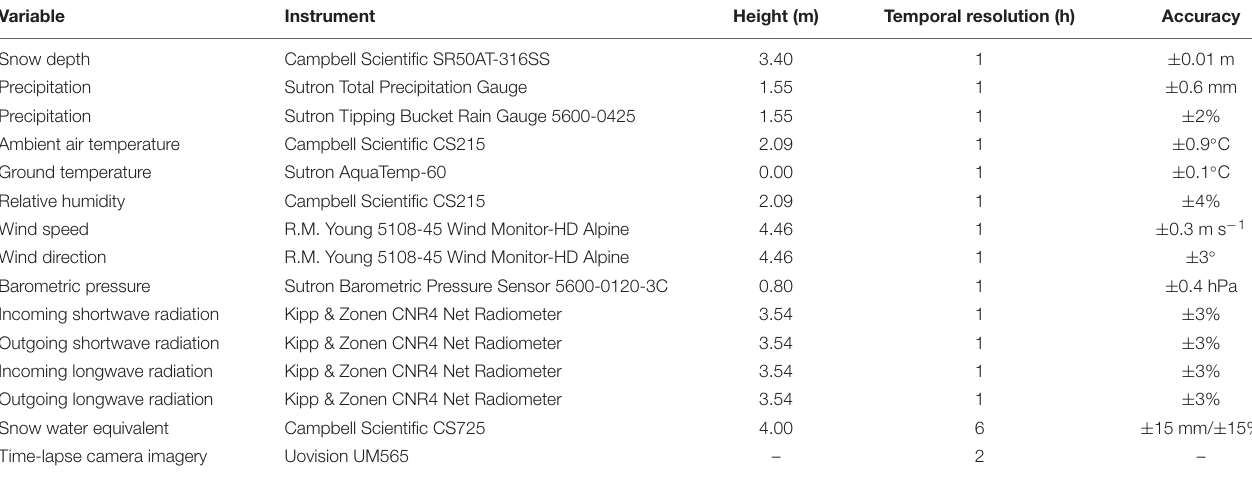
TABLE 1 | Variables measured by the automatic weather station instruments. Variable Instrument Height